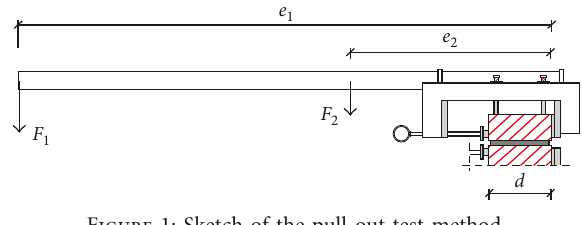
Figure 1: Sketch of the pull-out test